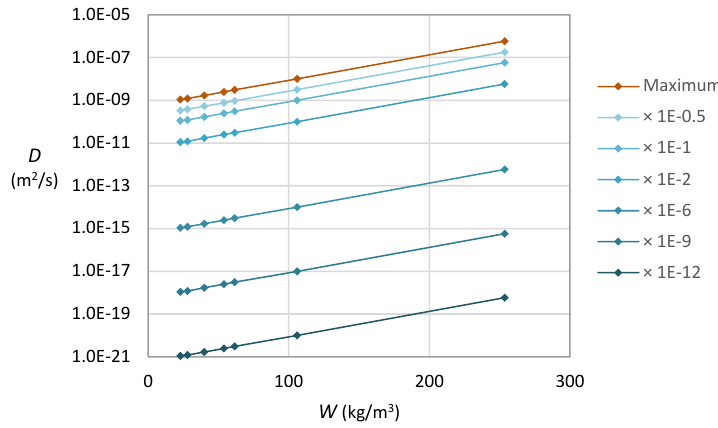
Figure 15. Liquid transport coefficient D used in Equation (2), plotted as a function of moisture content W . Effects of varying these liquid transport properties are examined in Section 3.5.2 (Figure